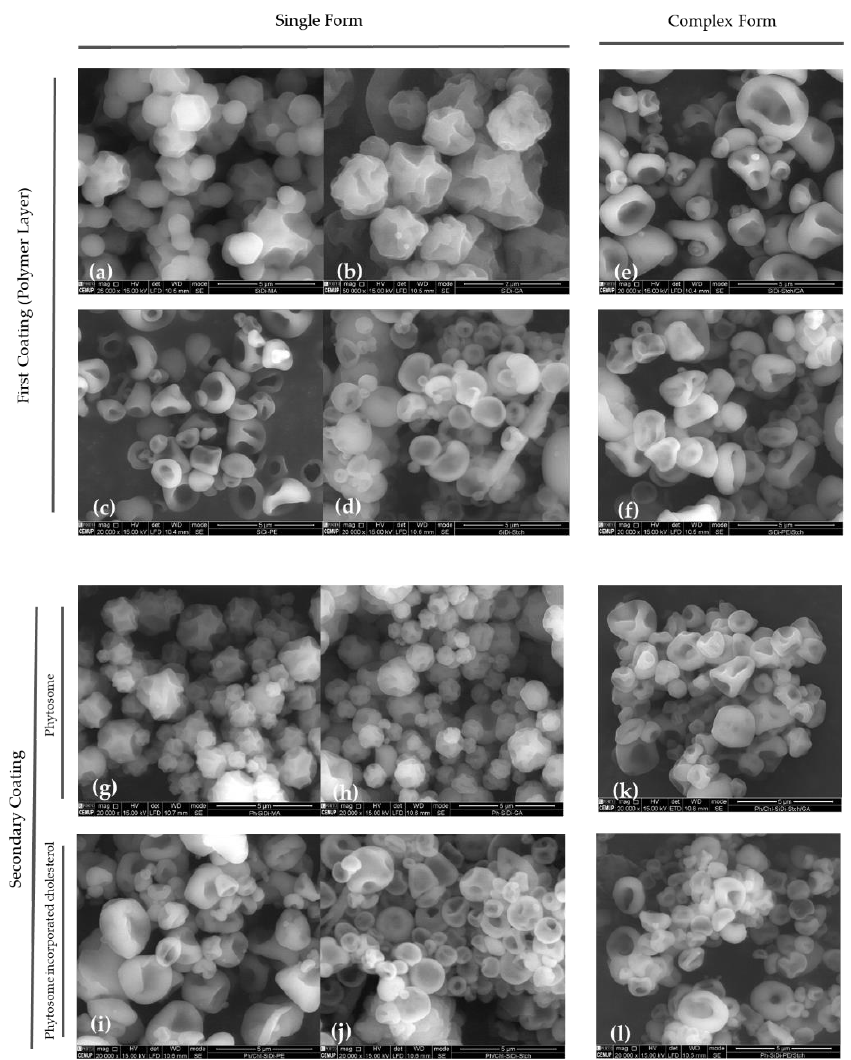
Figure 3. Surface morphology of the final products regarding first and secondary coatings. First coat- ing: ( a ) Maltodextrin; ( b ) gum Arabic; ( c ) pectin; ( d ) starch; ( e ) starch/gum Arabic; ( f ) pectin/starch. Secondary coating: ( g ) Maltodextrin; ( h ) gum Arabic; ( i ) pectin; ( j ) starch; ( k ) starch/ gum Arabic; ( l ) pectin/